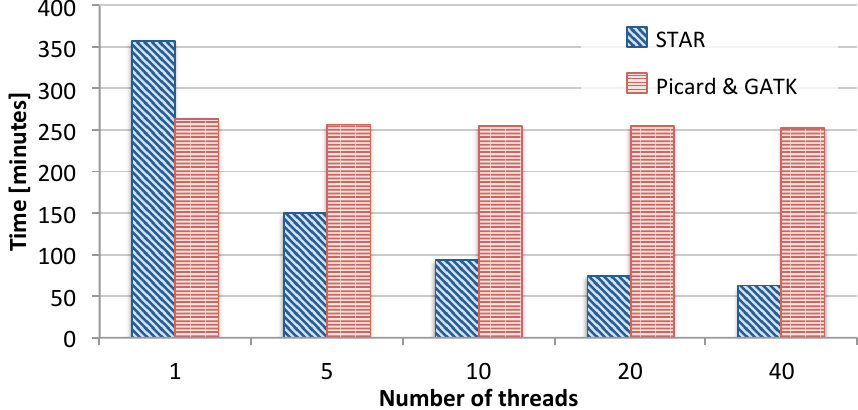
Figure 2. Scalability bottlenecks of the different tools in the GATK RNA-seq